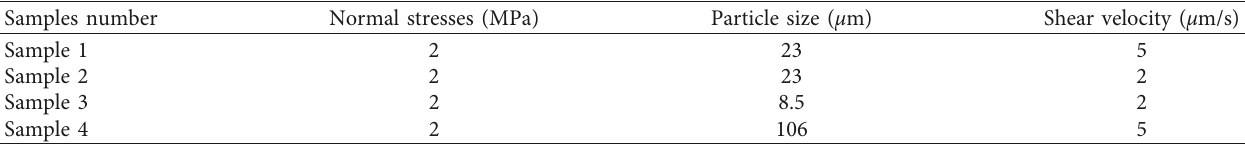
Table 1: The parameters of four experimental